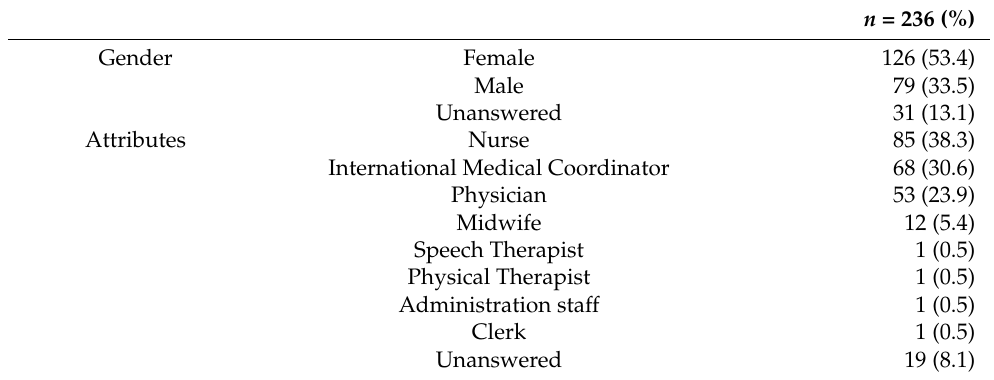
Table 4. Demographic data of the